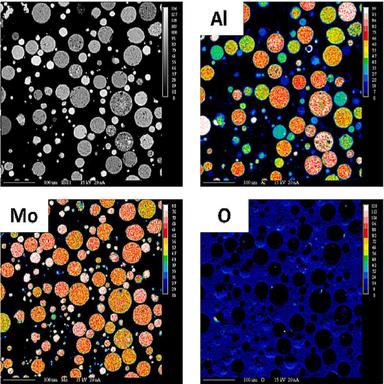
BSE image of the larger particle and EPMA elemental mapping of Al, Mo, and O contents.